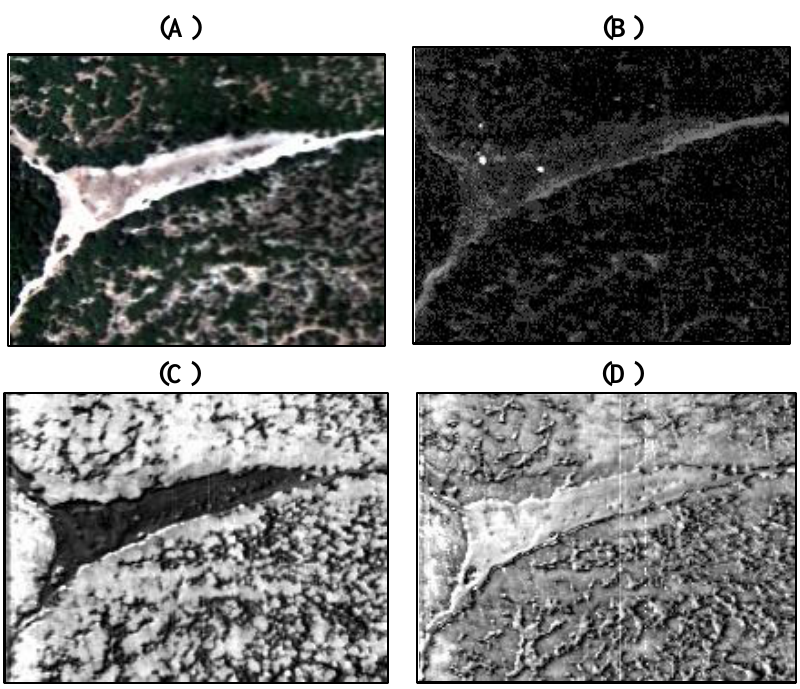
Figure 11. Anomaly detection on a bare-soil field: ( A ) R(630 nm) G(550 nm) B(430 nm) AISA-Dual image (31 October 2009; 10:10 GMT; midlatitude summer model; 30.2° solar zenith, 141.2° azimuth angle, 1.5 m spatial resolution, 198 spectral bands), ( B ) RXD